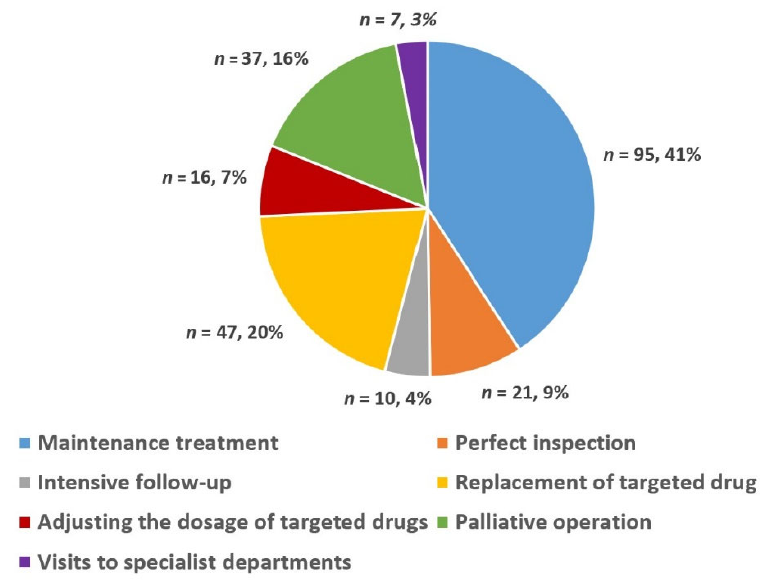
Figure 3. Choice of different treatment methods for advanced GIST after MDT discussion.